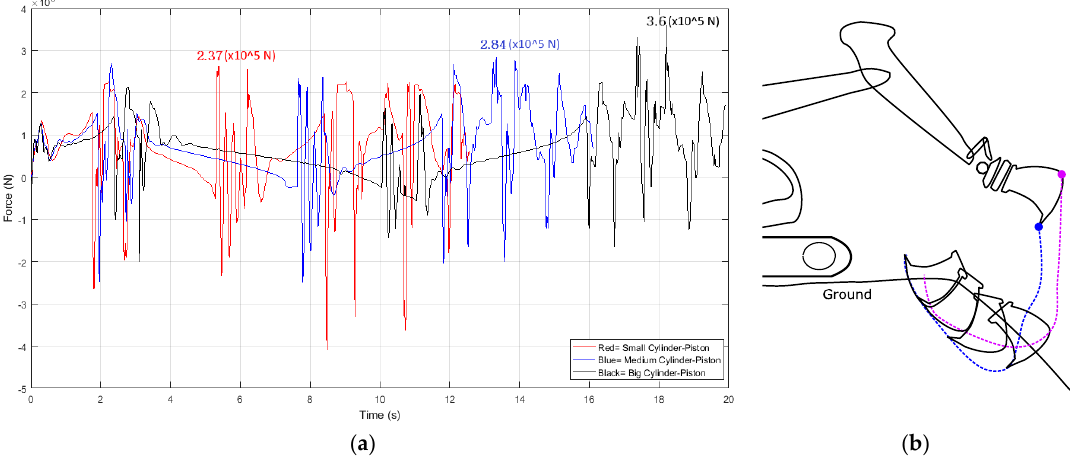
Figure 9. ( a ) Comparison of pick force for three types of arm-attached cylinder; ( b ) schematic for a sample trenching movement.